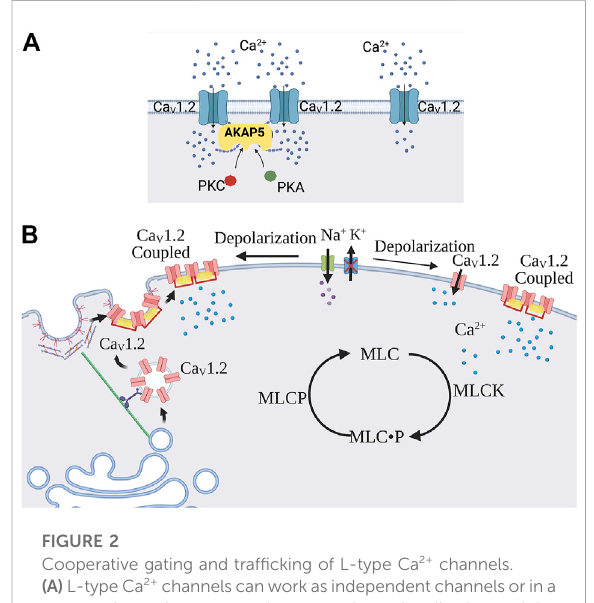
FIGURE 2 Cooperative gating and traf fi cking of L-type Ca 2+ channels. (A) L-typeCa 2+ channels canworkas independent channels orina cooperative gating manner due to proximate localization and the formation of connections at the Ca V 1.2 C-terminus. Cooperatively gated channels exhibit functional coupling properties, such as synchronous opening, higher Po, and more persistentcurrentcomparedtoindividuallygatedchannels.AKAP5 (mouse numbering), PKC, and PKA play a critical role in the promotion of functional coupling properties. (B) Depolarization enhances the traf fi cking of L-type Ca 2+ channel subunits to the plasma membrane. This key biological process entails the movement of vesicles from the Golgi apparatus to caveolae strategically positioned on the plasma membrane. Abbreviations: AKAP5, A-kinase anchoring protein -5; PKA, Protein kinase A; PKC, Protein kinase C; MLCK, Myosin light chain kinase; MLCP, Myosin light chain